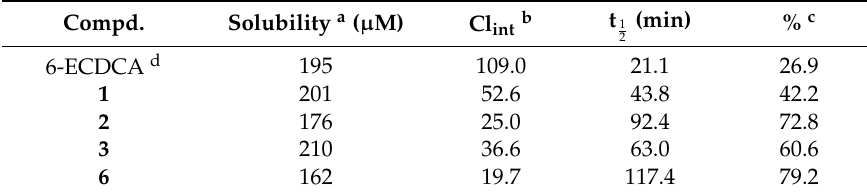
Table 2. Physicochemical properties of selected compounds.